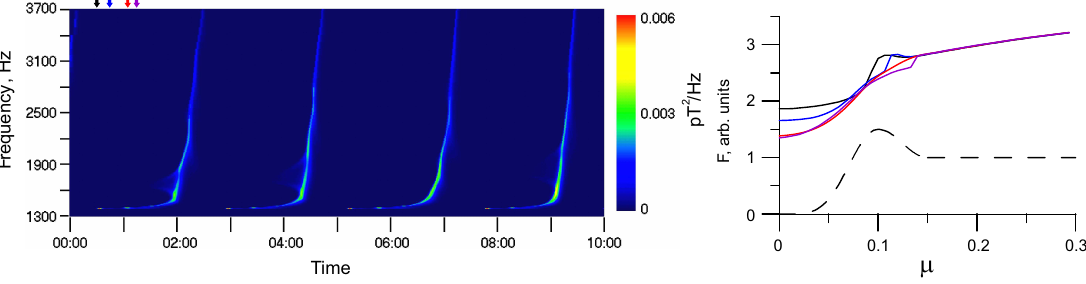
Fig. 6. Periodic generation of wave intensity spikes in the case of losses due to drift and nonmonotonic distribution (19) of energetic electrons in the the source; 1 = 0 . 5, δ 1 = 1, æ 1 = 0 . 05, all other parameters as in Fig. 4.